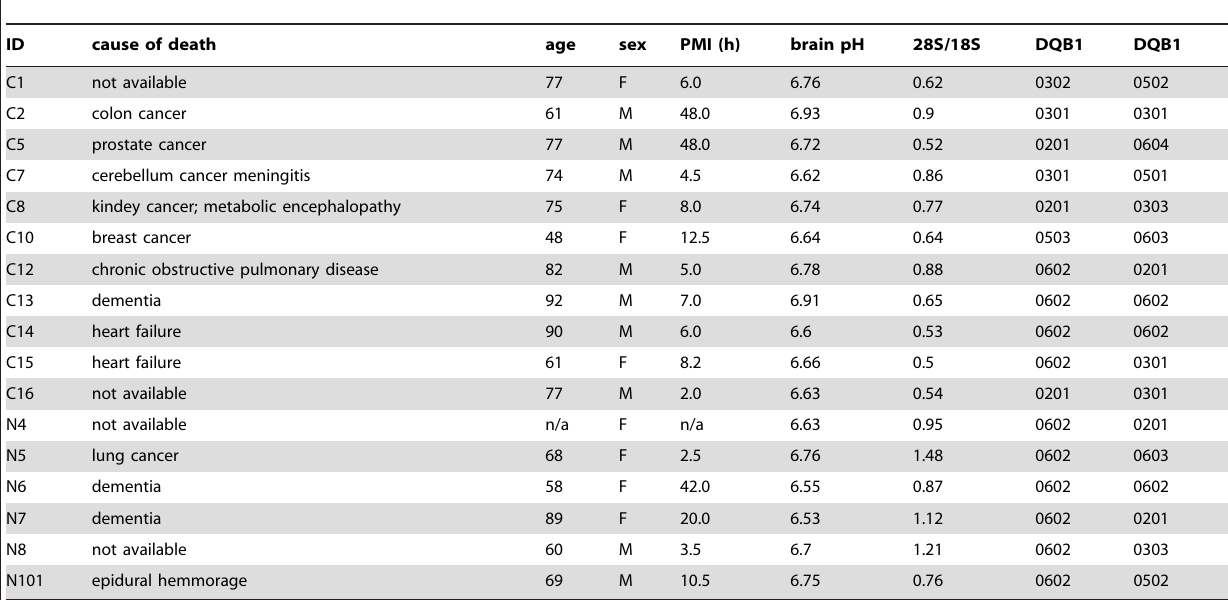
Table 1. Demographic and RNA quality data of human brain tissue used for